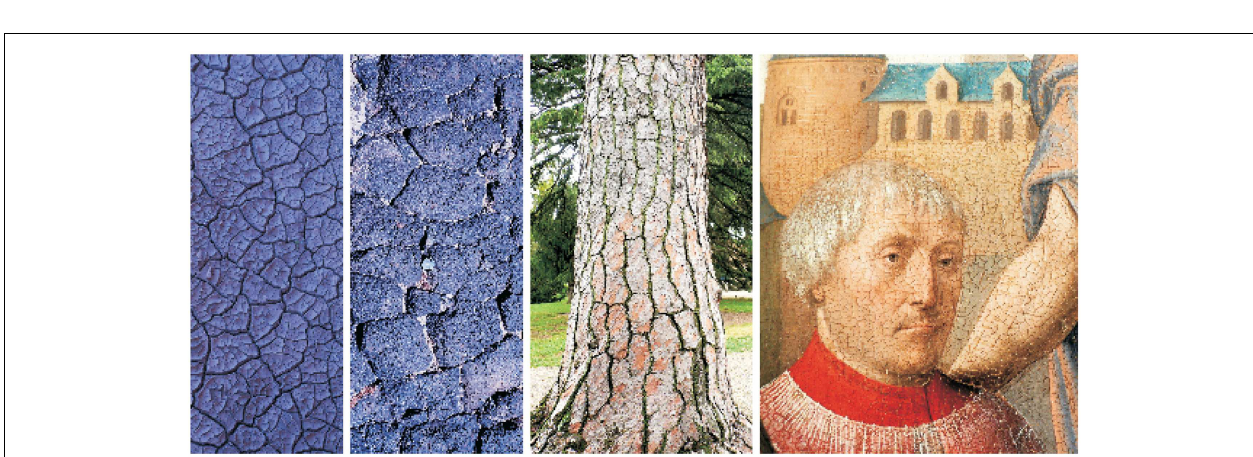
FIGURE 2 | Regular patterns of localized cracks as the signature of strain localization lattices . From left to right: Dried mud; Lava cracked during solidification (near Amboy crater); Bark of a maritime pine ( Pinus pinaster ); Cracks in a detail of a painting by J. Provost (“Saint Jean-Baptiste,”Valenciennes, Musée des Beaux